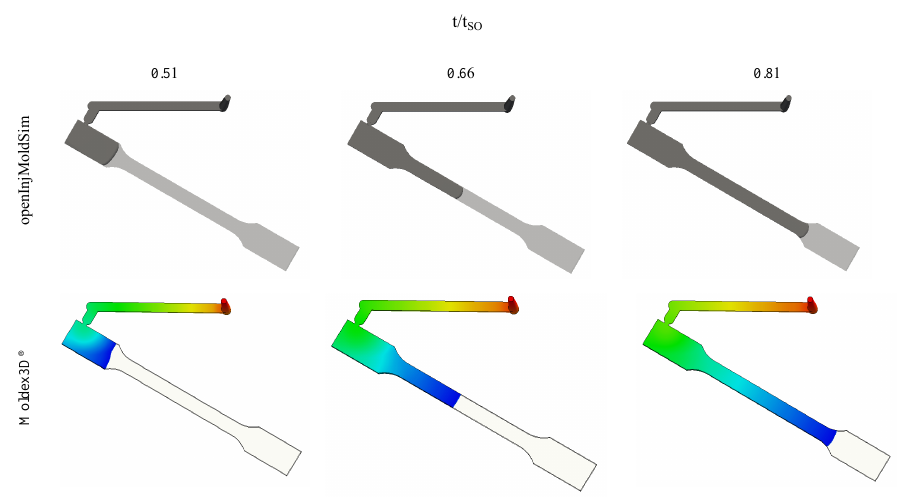
Figure 14. Melt front location for t / t SO = 0.51, 0.66, and 0.81 predicted by both openInjMoldSim and (cid:13) Moldex 3 D R [11].